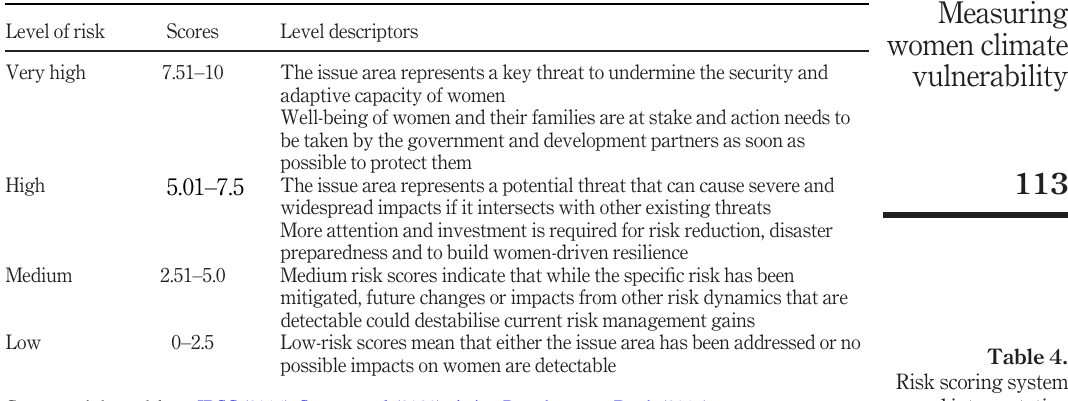
Table 4. Risk scoring